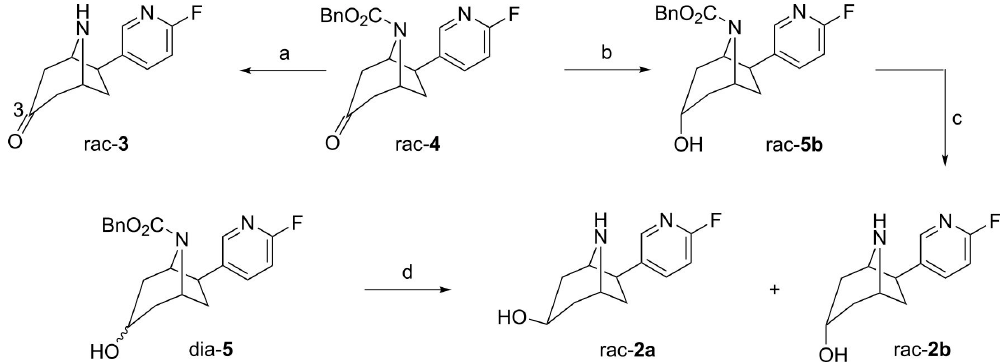
Figure 2. Synthesis of reference compounds. Conditions : ( a ) Pd/C (10%), cyclohexene, EtOH, reflux, 16 h, 59%; ( b ) 1. L -Selectride, THF, − 78 °C, 2 h; 2. NaOH, H 2 O 2 , H 2 O, THF, room temperature (rt), 1 h, 97%; ( c ) Pd/C, cyclohexene, EtOH, reflux, 17 h, 28%; and ( d ) HBr (33% in AcOH), Et 2 O, 0 °C, 5 h, 23% rac - 2a , 34% rac - 2b .